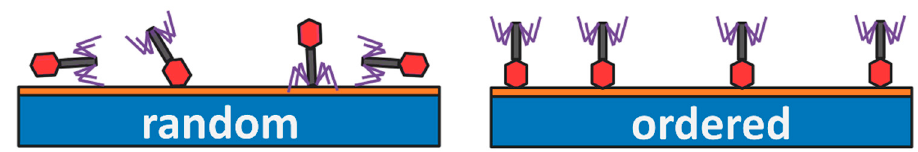
Figure 2. Upon deposition of phages at the solid surface, the entropy favors the random orientation of virions, which restrict the possibility of interactions between fibers (marked in violet) with target bacteria. Proper orientation of virions allows for more receptor binding proteins (RBPs) to participate in the sensing process.